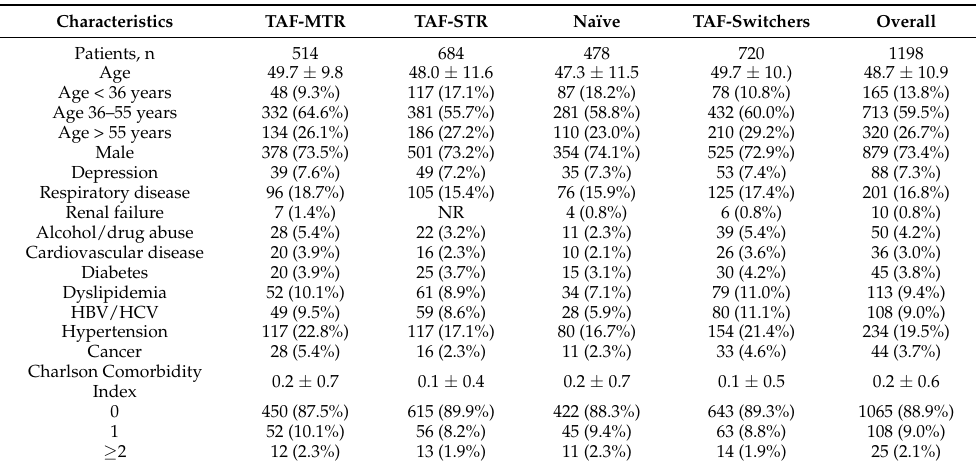
Table 2. Demographic and clinical characteristics of patients with TAF-based regimen (overall and stratified by MTF/STR and naïve/switchers). Continuous variables are reported as mean ± standard deviation and categorical variables as numbers and percentages in brackets. Characteristics TAF-MTR TAF-STR Naïve TAF-Switchers Overall Patients,